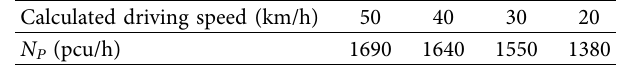
Table 6: Possible capacity of the road